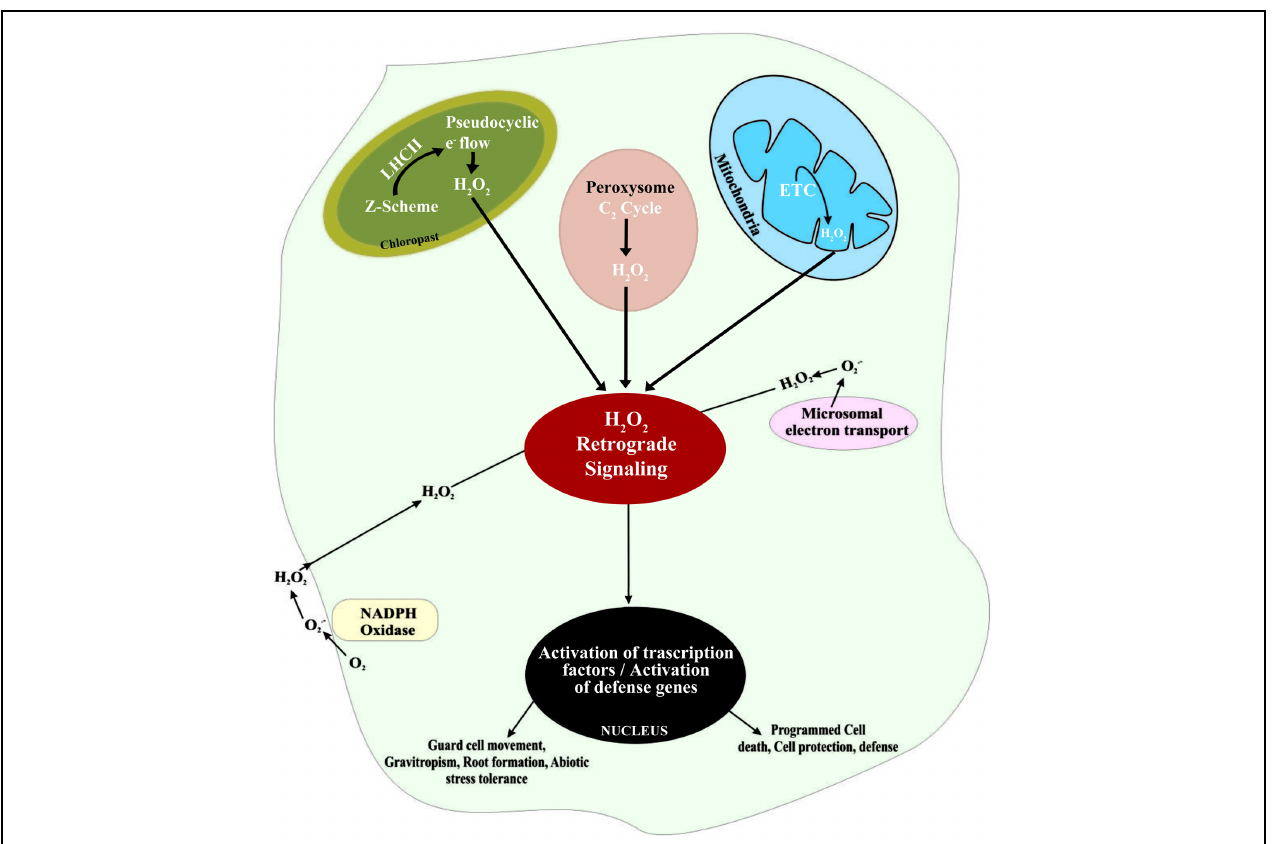
FIGURE 1 | Schematic representation of H 2 O 2 generation in different intra- and extra-cellular sites and the subsequent signaling associated with the regulation of defense gene expression in plant cells.